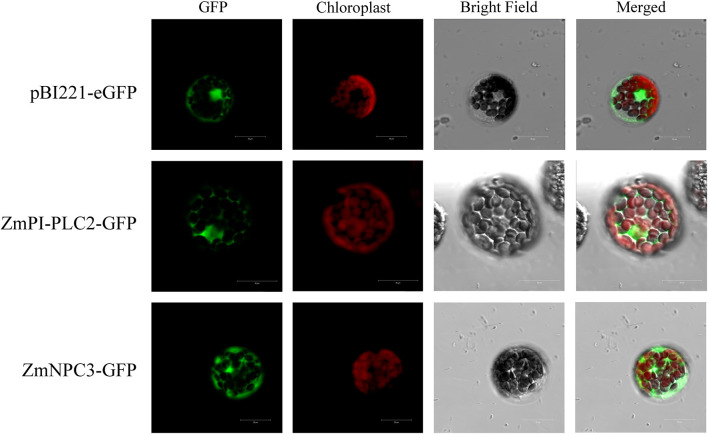
Subcellular localization of ZmPLC proteins in Arabidopsis leaf protoplasts.